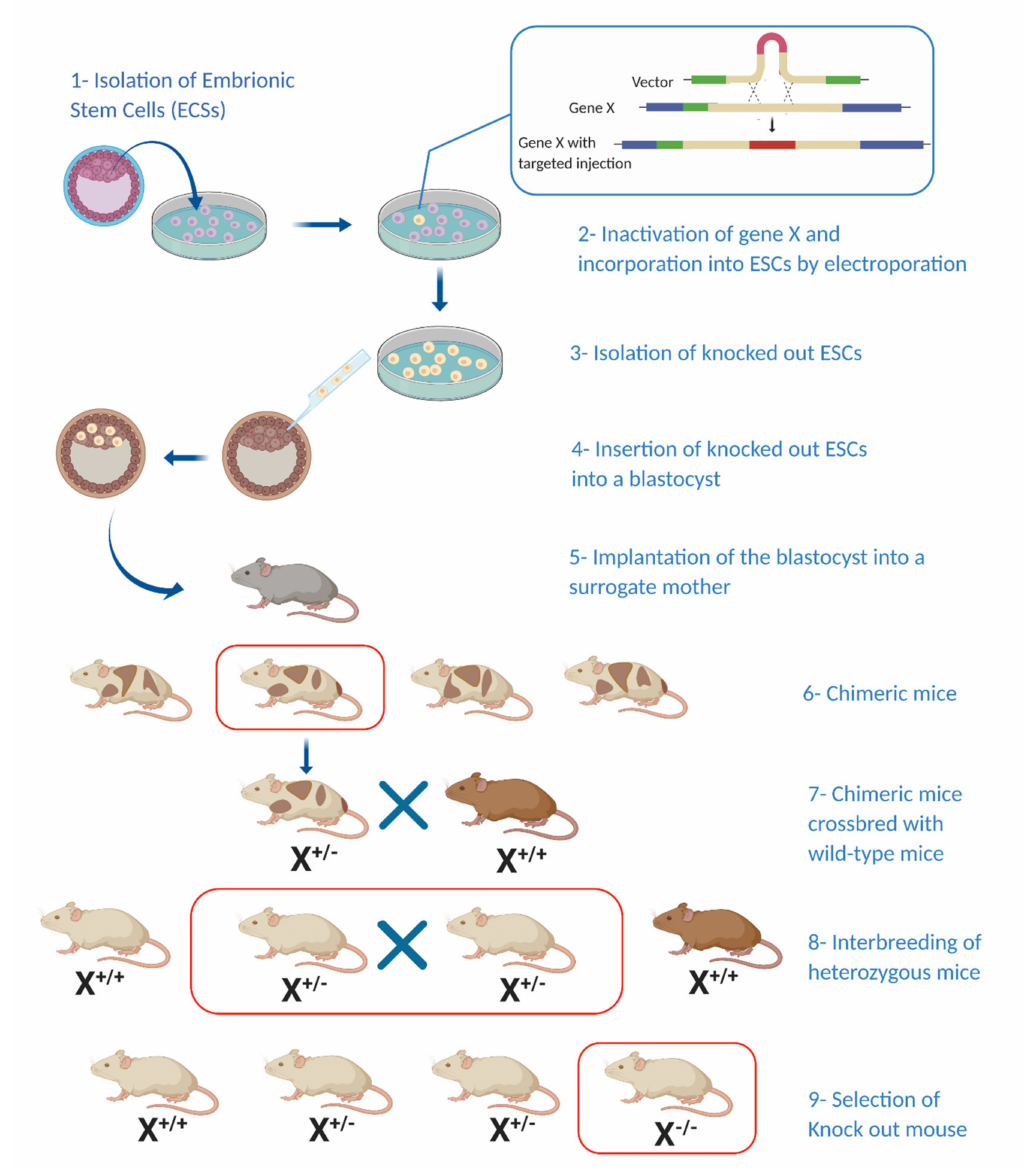
Figure 1. Generating a knockout mouse model: Generation of a knockout mouse model involves the incorporation of a predesigned target gene into embryonic stem cells (ESCs) ( 1–3 ) followed by their incorporation into a blastocyst and later into a surrogate mouse ( 4–5 ). Chimeric o ff spring are crossbred with wild-type mice and new-born heterozygous mice are bred again to produce homozygous o ff spring bearing the mutation of interest ( 6–9 ). (X * / * —Hetero / homozygosity for target gene) (Illustration created with